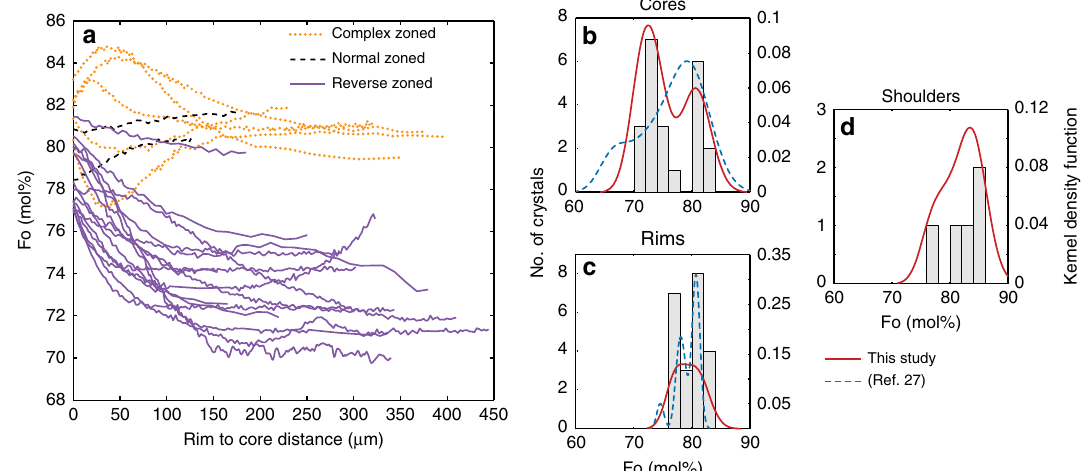
Fig. 2 Summary of olivine compositions from 2008 Llaima scoria deposits. a Rim to core electron microprobe %Fo traverses, that show mainly reverse zoning and the presence of “ shoulders ” in some crystals. b – d histograms of compositions of cores ( b ), rims ( c ), shoulders ( d ). The black line is a kernel density function, the dashed line are the data from older Llaima eruptions 25,27 . See text for more